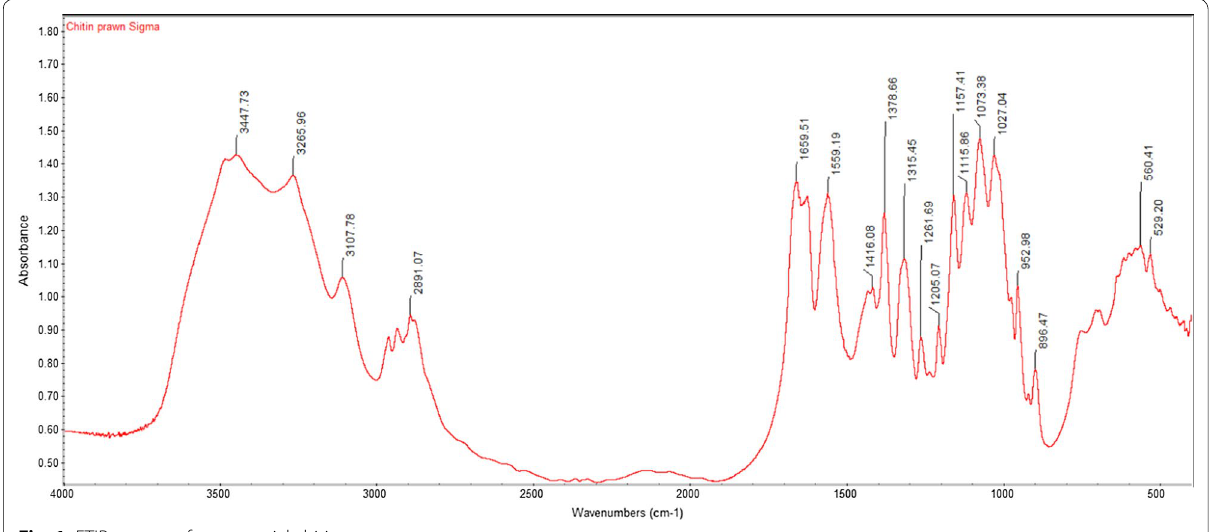
Fig. 1 FTIR spectra of commercial chitin